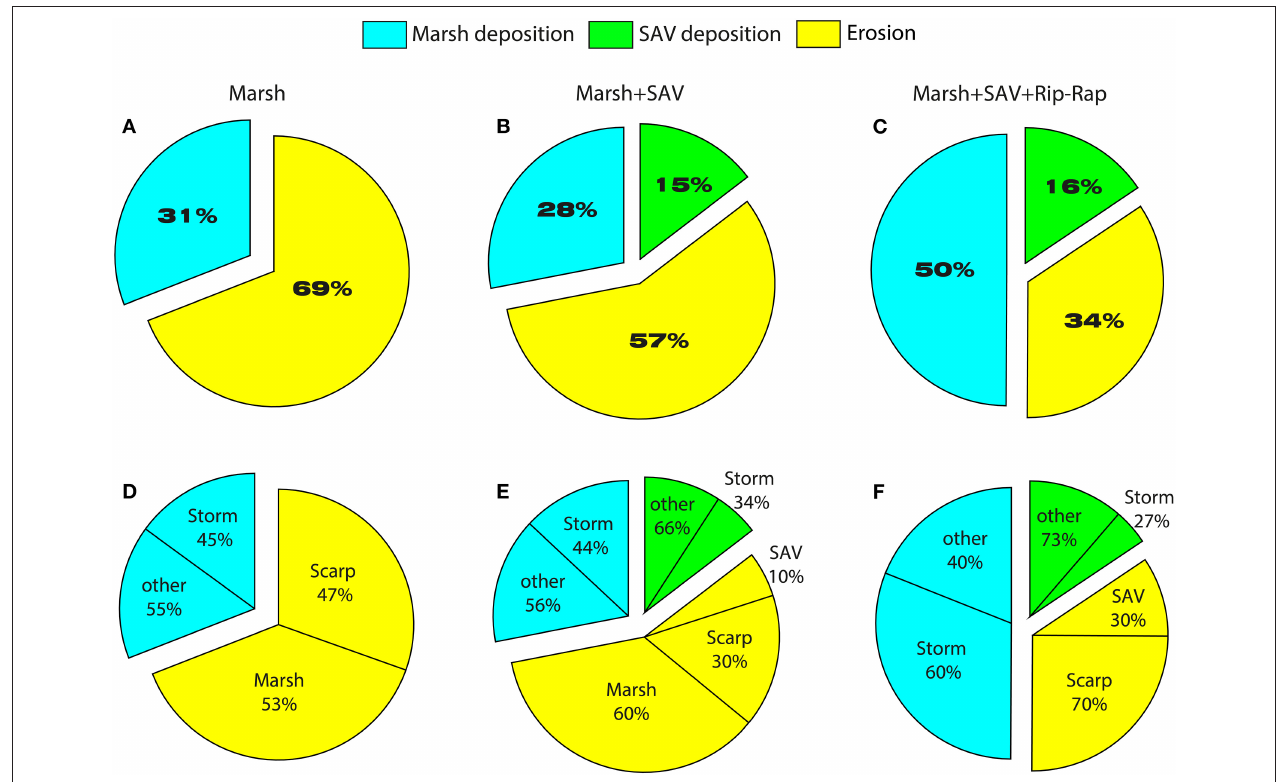
FIGURE 9 | Deposition and erosion rates for each scenario. (A,D) refers to the case with the only marsh; (B,E) refers to the case with marsh and SAV; (C,F) refers to the case with marsh, SAV, and rip-rap. (A) Percentage of erosion and deposition in the marsh and (D) subdivision of the deposition depending on whether it was caused by storm or other and erosion depending on whether it was marsh or scarp. (B) Percentage of deposition in the marsh, in the SAV, erosion and (E) subdivision of the deposition according to whether it was caused by storm or other and erosion depending on whether it was a marsh, SAV or scarp. (C) Percentage of deposition in the marsh, in the SAV, erosion and (F) subdivision of the deposition according to whether it was caused by storm or other and erosion depending on whether it was a marsh, SAV or